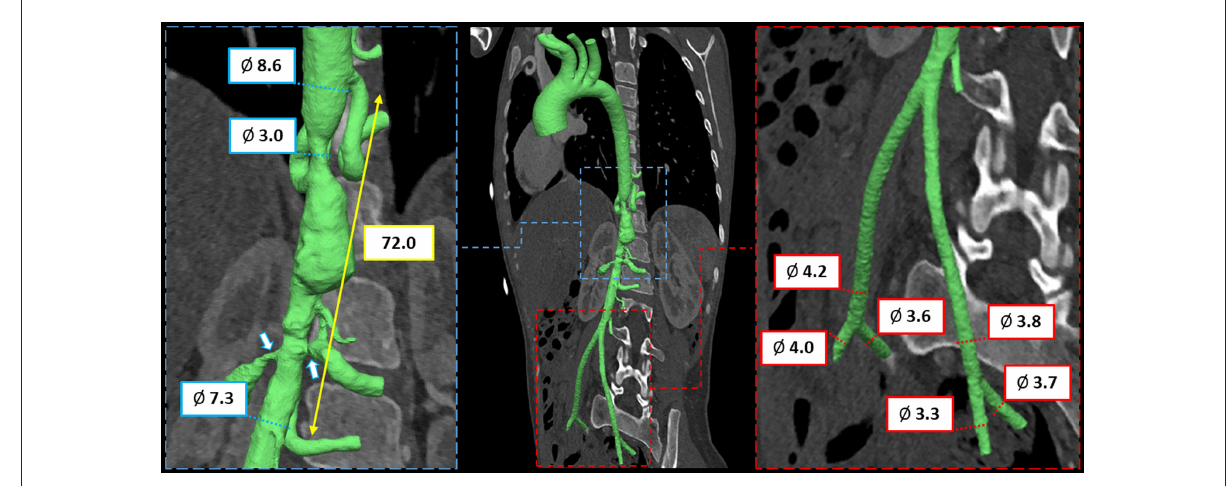
FIGURE2 Antero-posterior (A) , latero-lateral (B) , and isometric (C) views of the virtual rendering of the 3D-printed model, replicated from patient-specific CT imaging; (D) 3D-printed model mounted on the in vitro planning platform.